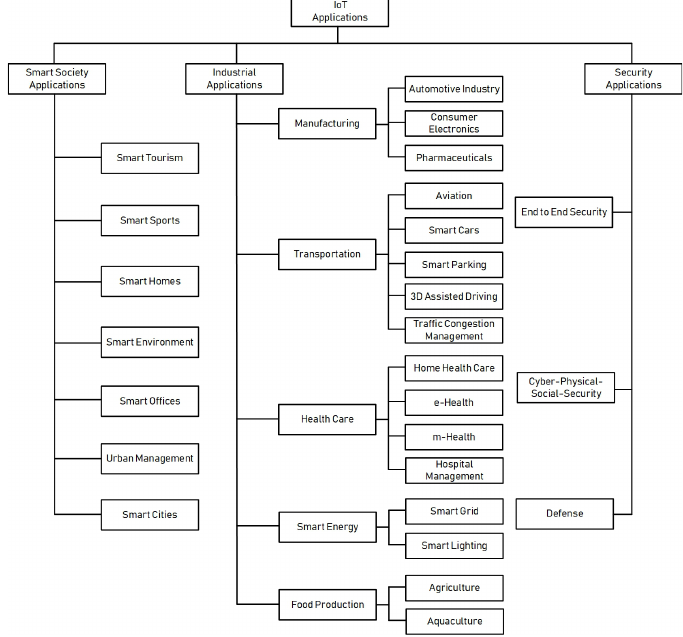
Figure 1. Summary of IoT